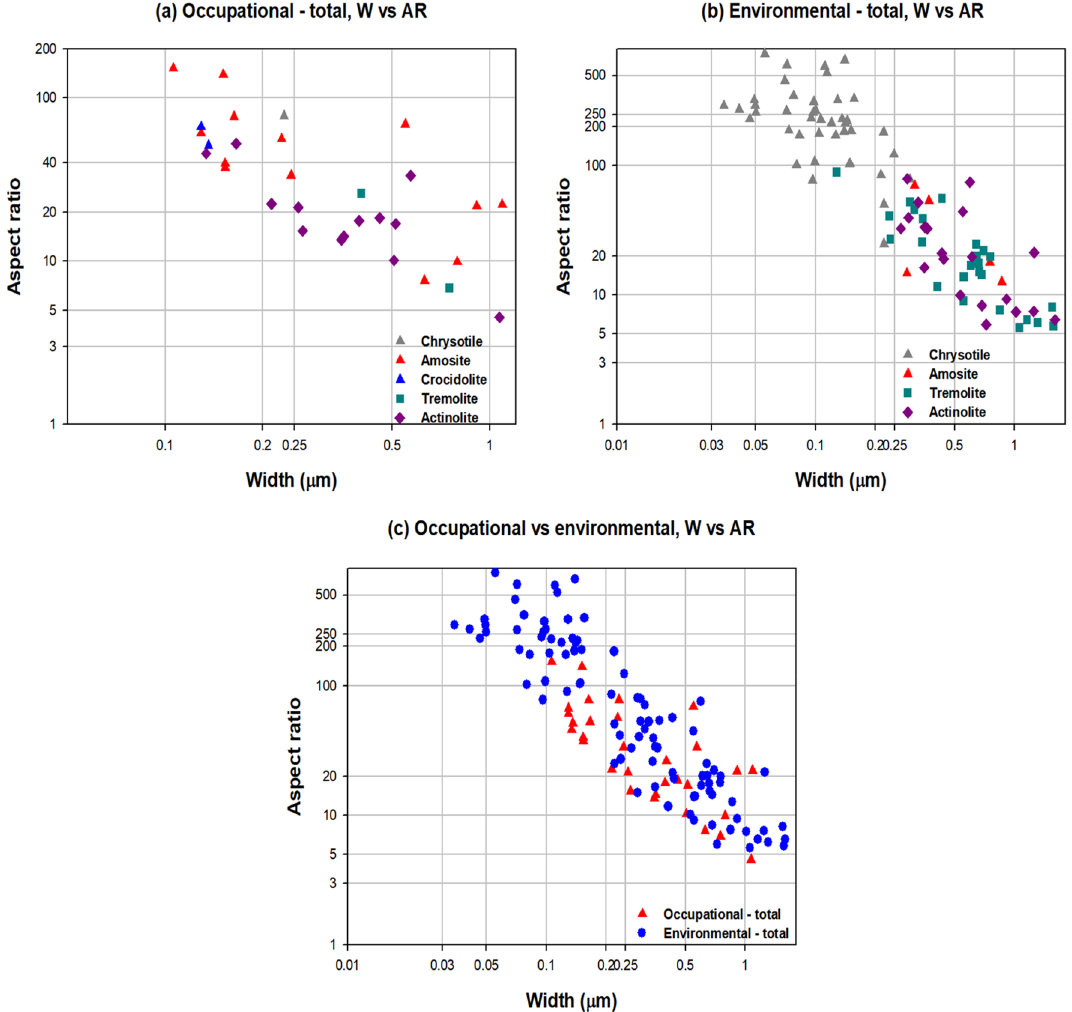
Figure 2. Distribution of asbestos fiber width and aspect ratio according to type of asbestos exposure. ( a ) Occupational—total, W vs. AR. ( b ) Environmental—total, W vs. AR. ( c ) Occupational vs. environmental, W vs.